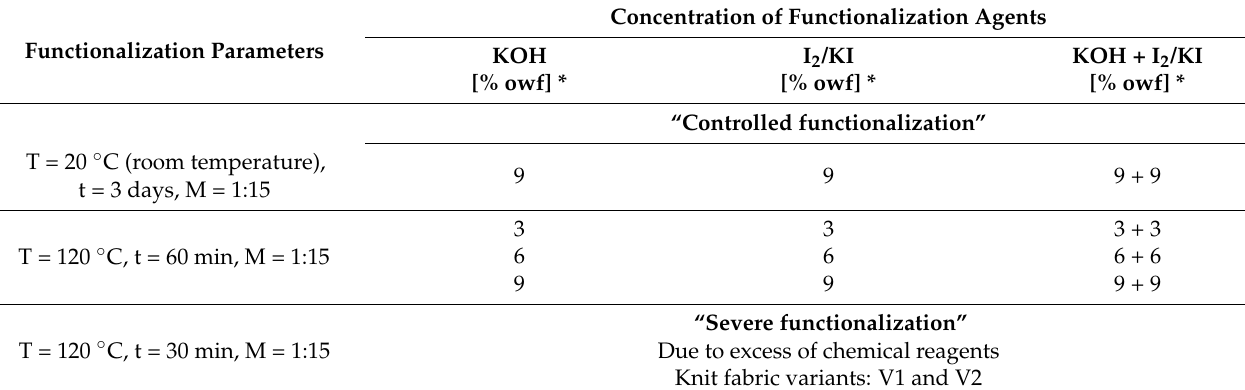
Table 1. Experimental protocol for the functionalization treatments. Functionalization Parameters